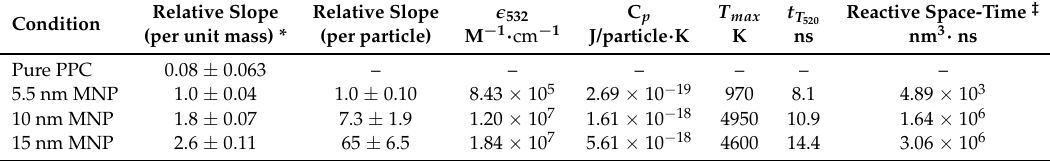
is the time the 520